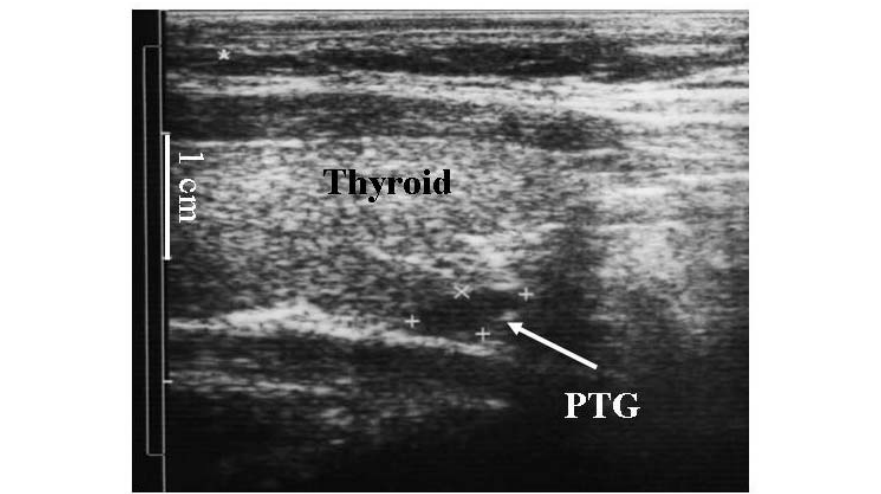
FIGURE 3 . PTG with diffuse hyperplasia in 41-year-old woman, on dialysis treatment 5 years, PTH 129.2 pg/ml (longitudinal section, linear probe 10 MHz).